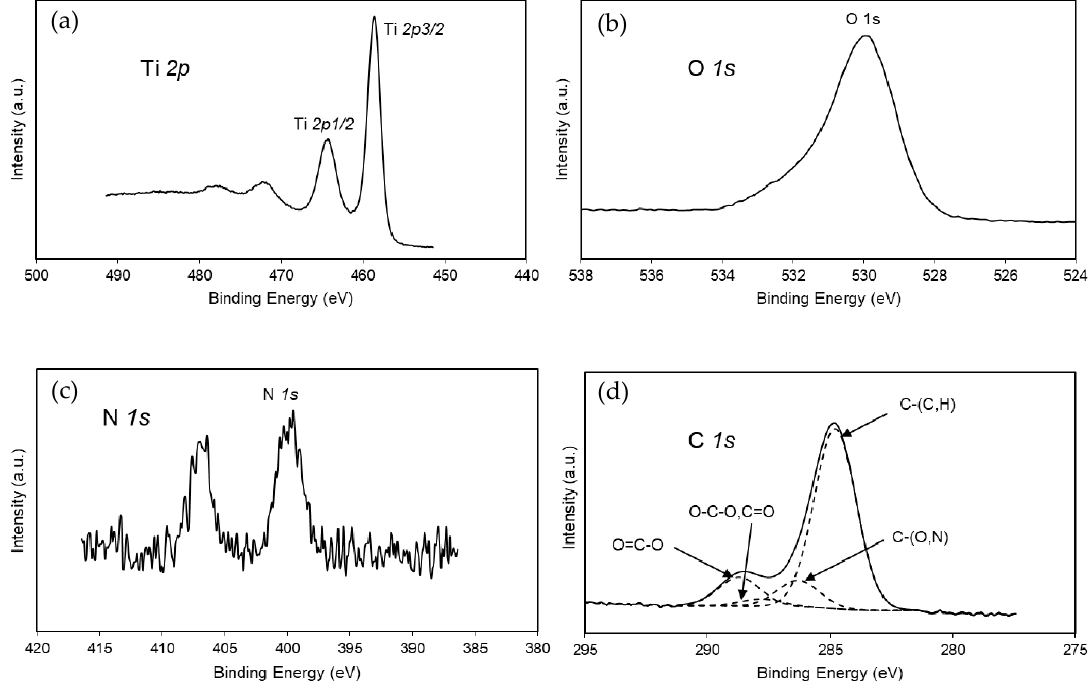
Figure 5. X-ray photo-electron spectroscopy (XPS) spectra of the TiO 2 / Fe0.5 / N43 sample: ( a ) Ti 2p region, ( b ) O 1s region, ( c ) N 1s region and ( d ) C 1s region.